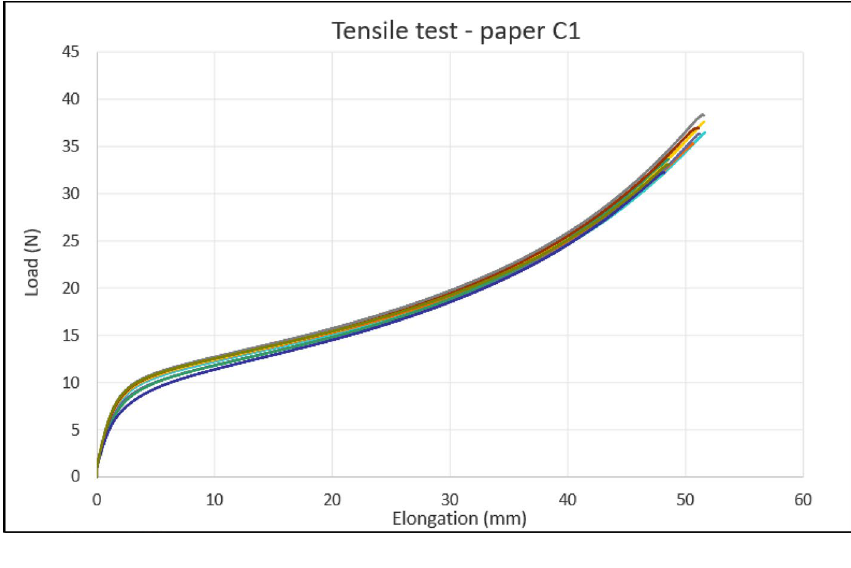
Fig. 27 Force elongation curves of individual specimen of paper